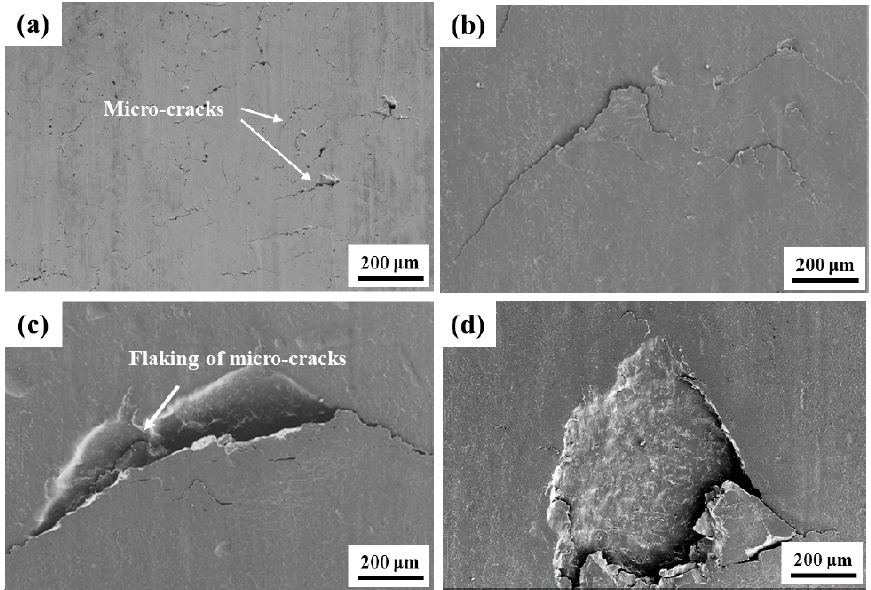
Figure 13. The propagation process of RCF cracks of the grinding processing sample. ( a ) Surface micro-cracks; ( b ) micro-crack propagation; ( c ) RCF crack propagation; ( d ) the surface large spalling.